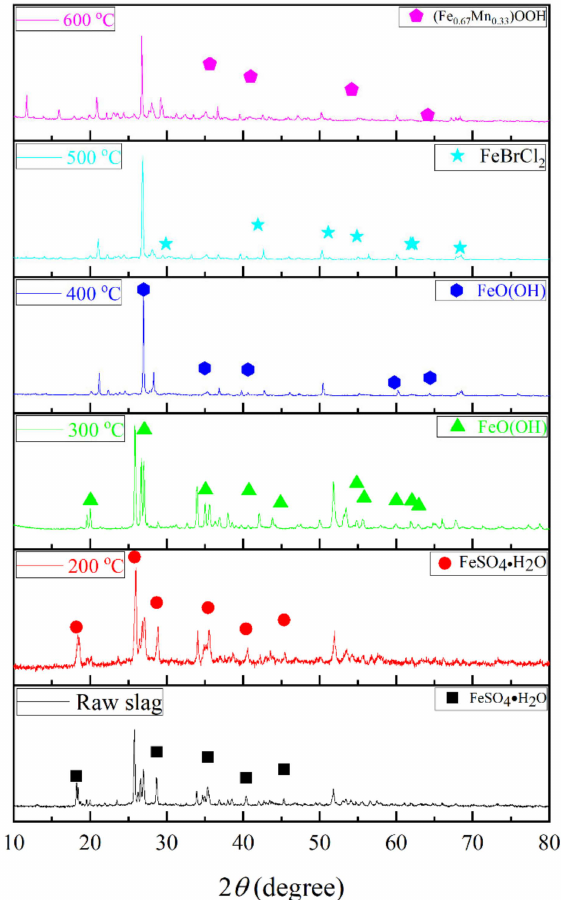
Figure 7. XRD of tantalum niobium